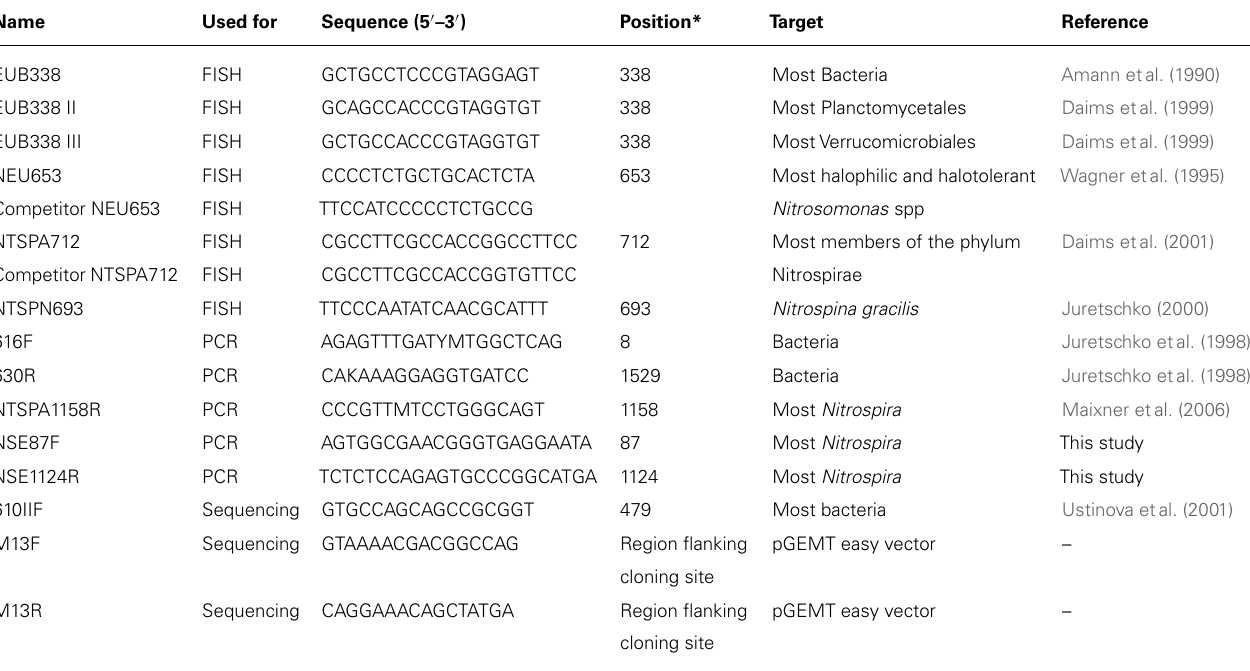
Table 1 | Oligonucleotide